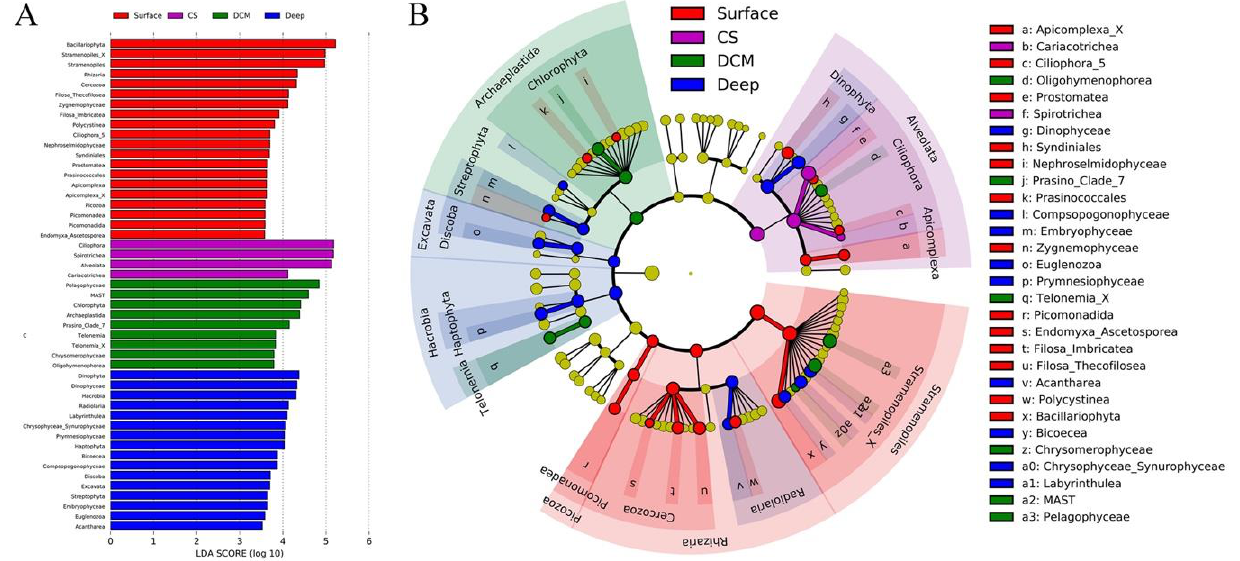
Figure 4. ( A ) Linear discriminant analysis Effect Size (LEfSe) analysis on selected OTUs among the four identified groups, Group Surface (surface waters), Group CS (coastal subsurface waters), Group DCM (deep chlorophyll maximum depth), and Group Deep (deep waters). Only lineages with Least Discriminant Analysis (LDA) values >3.5 are displayed. The multiclass analysis strategy is less strict (one-against-all). Group differences are represented by the color of the most abundant lineages (red: Surface; purple: CS; green: DCM; blue: Deep; and yellow: nonsignificant). ( B ) Cladogram indicating the phylogenetic distribution of the protistan lineages associated with the four groups. Circles indicate phylogenetic levels (from domain to class) in reverse order. The diameter of each circle is proportional to the abundance of the given protistan taxon.